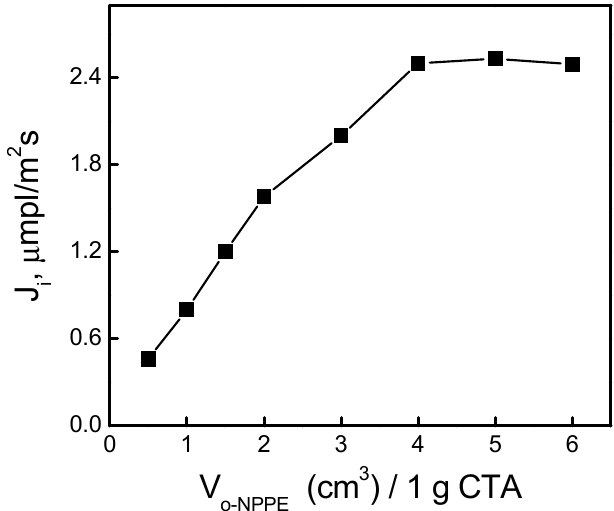
Figure 5. The effect of o -NPPE plasticizer on Ag(I) transport through a PIM containing KP. Source phase: 1.0 × 10 − 3 M AgNO 3 , pH = 4.0; membrane: 25.0 mg CTA; 0.050 M KP, receiving phase: 0.10 M Na 2 S 2 O 3 .